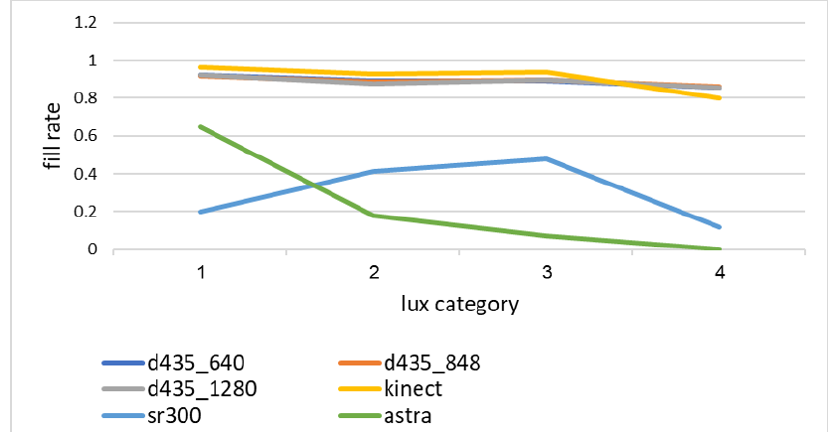
Figure 4. Fill rate by light intensity for all depth sensors, considering only objects within the camera